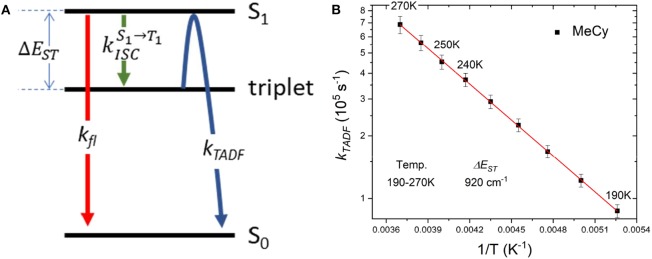
(A) Kinetic scheme for emission from AuBZI. (B) Arrhenius plot of the temperature-dependent lifetime data for AuBZI in MeCy recorded from 190 to 300 K, along with fits to the data according to Equation 1.